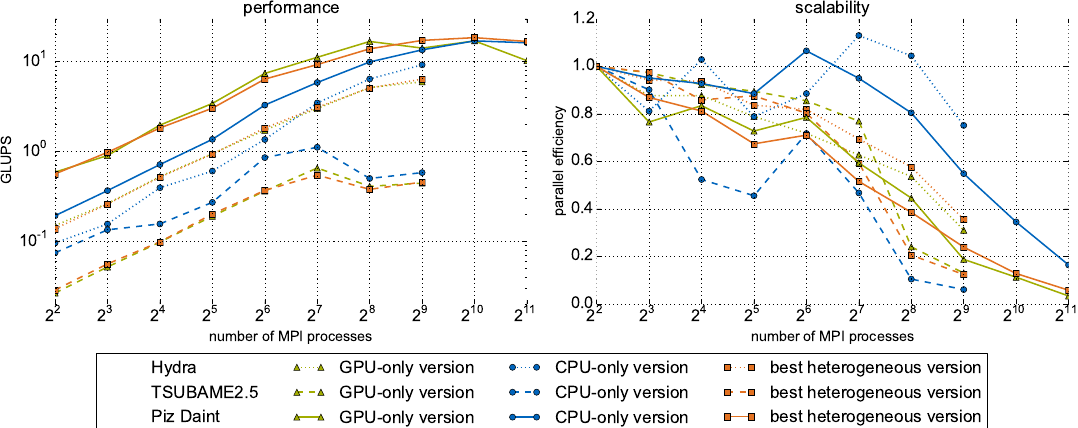
Figure 11. Strong scaling performance in GLUPS ( left ) and scalability expressed by parallel efficiency ( right ) for parallelization in x / y / z -direction. Axes assignments, line markers, and color coding are equal to Figure 10.